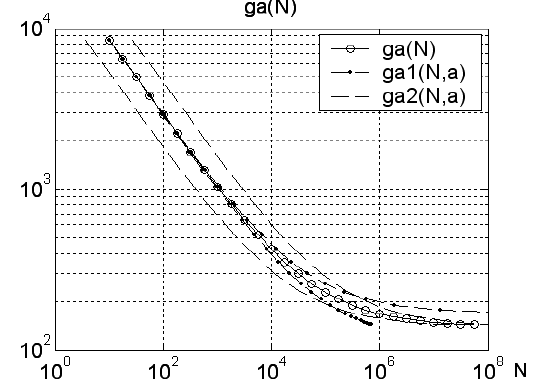
Fig. 7. Endurance characteristics probability model of